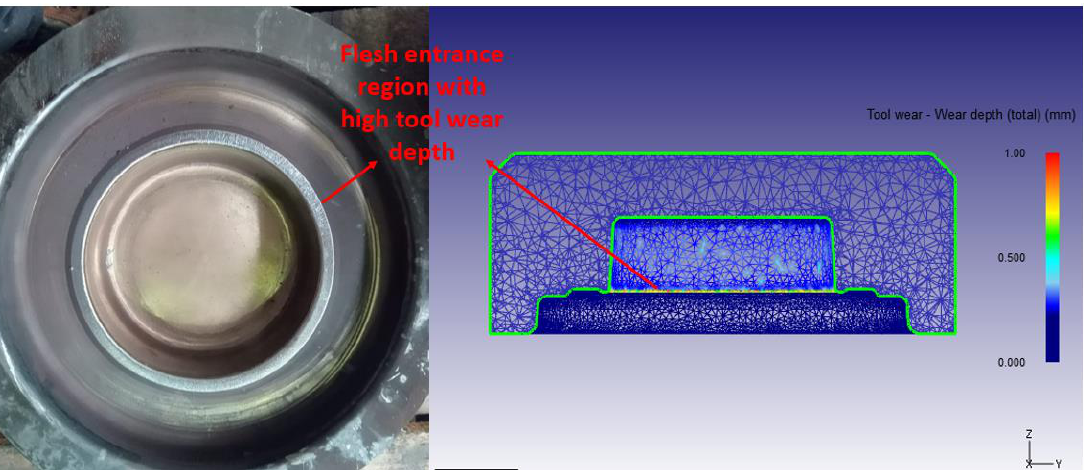
Figure 13. Tool wear pattern: ( Left ) Actual top die after 300 cycles, ( Right ) Wear depth distribution pattern from the numerical model.